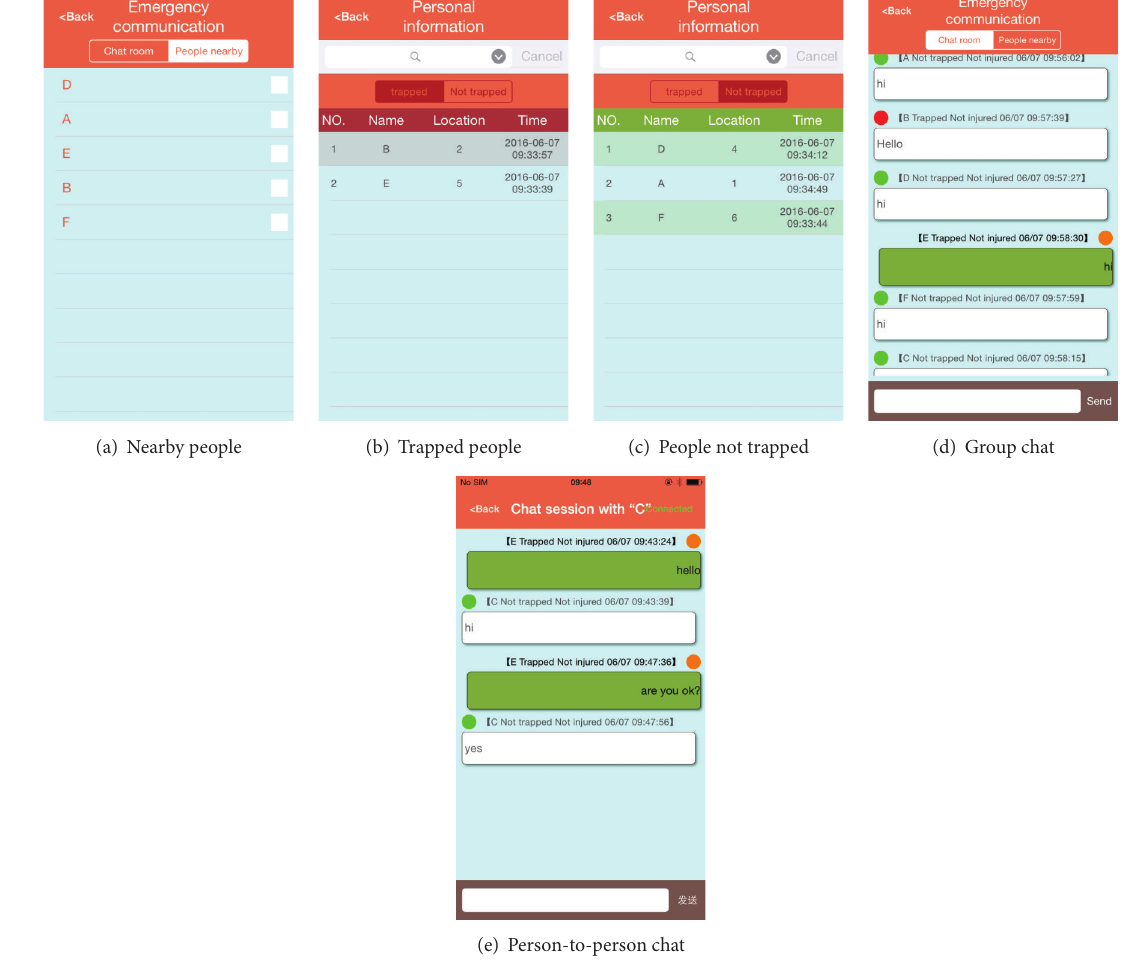
Figure 6: Information on C’s smartphone.